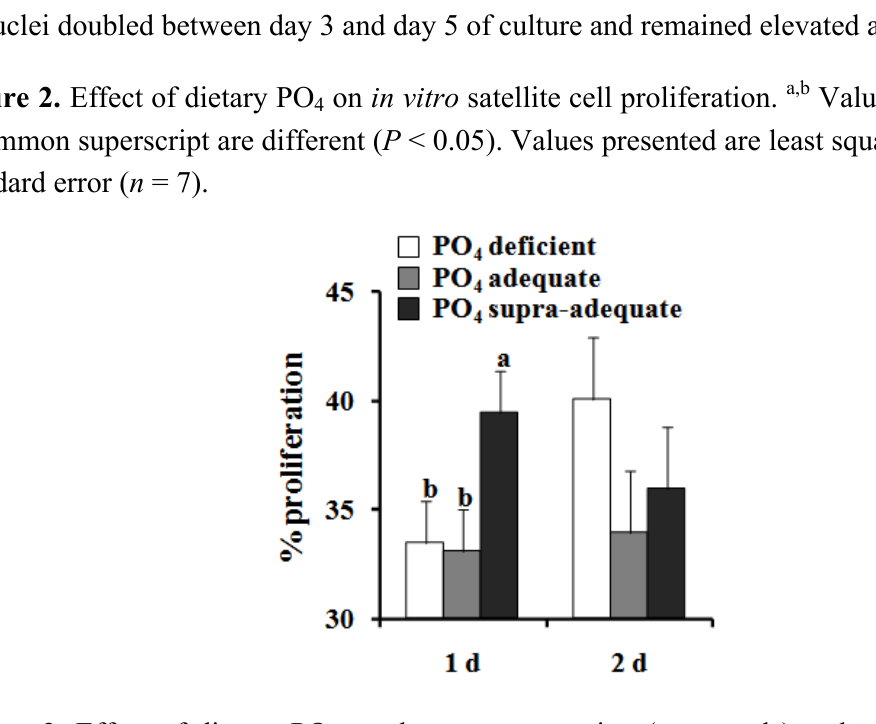
Figure 3. Effect of dietary PO on the gene expression (top panels) and in vitro protein 4 (bottom panels) of myogenic regulatory factors: ( A , D ), Pax7, ( B , E ) MyoD, and ( C , F ) myogenin in satellite cells isolated from neonatal pigs. Values presented are least square means and standard error of values; either percentage of stained nuclei or normalized to cDNA concentrations ( n = 7). a,b Values within a timepoint not sharing a common superscript are different ( P <